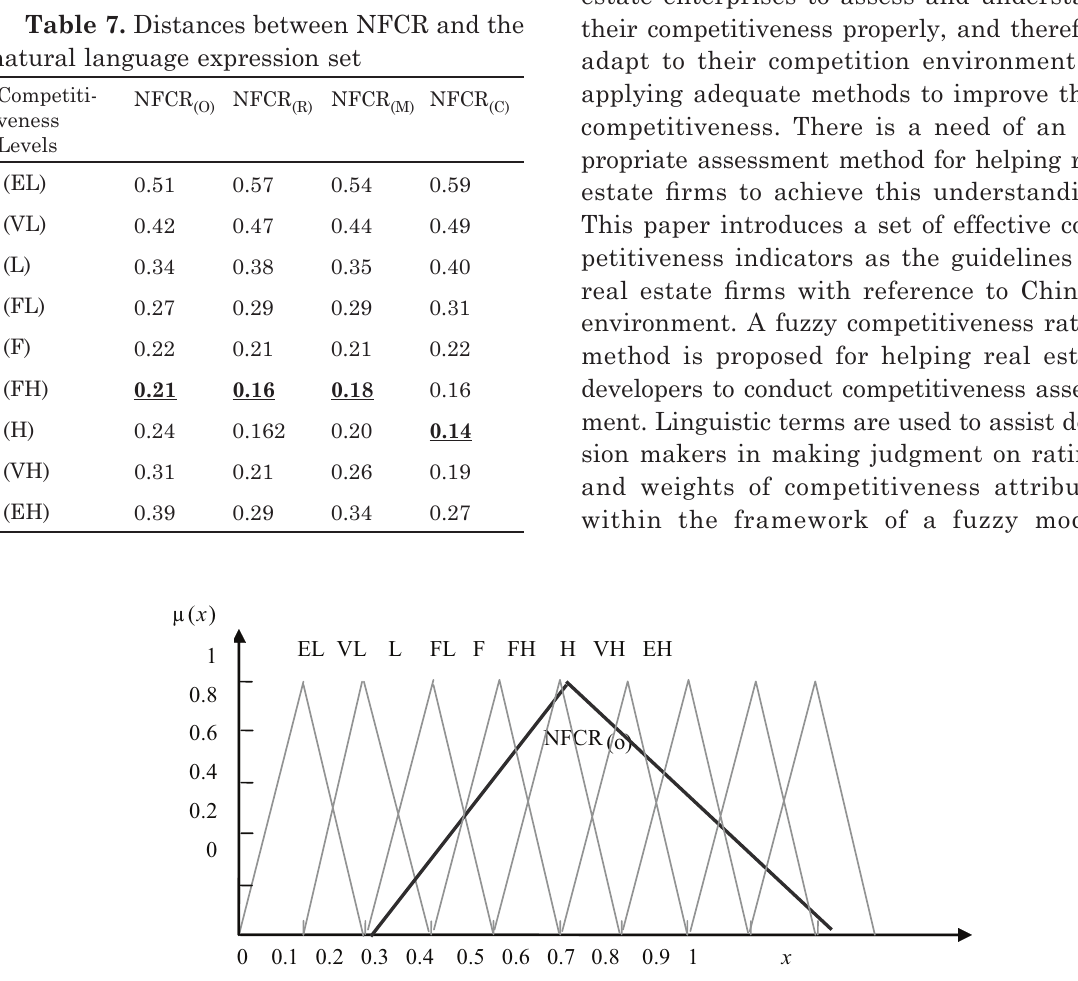
figure 3. Match nfCr